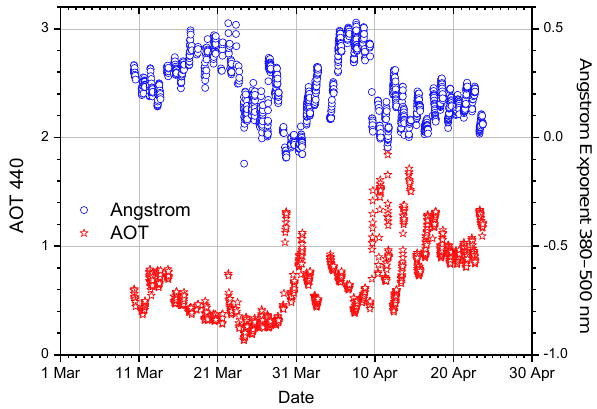
Figure 6. Aerosol optical thickness (AOT) at 440nm and the ex- tinction Ångström exponent at 380–550nm wavelengths provided by AERONET in Mbour for the period of March–April 2015.